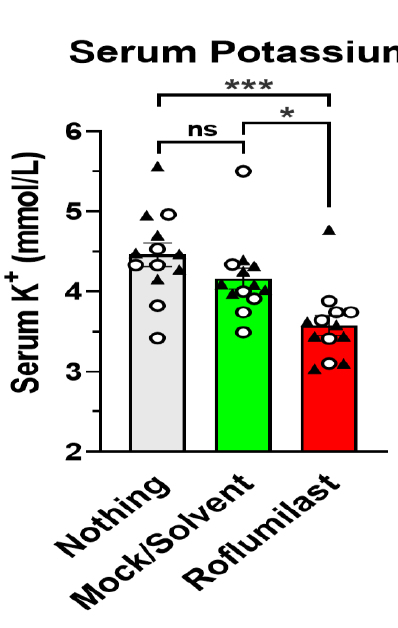
Figure A1. Treatment with the PDE4 inhibitor Roflumilast reduces serum potassium levels. Male (filled triangles) and female (open circles) mice were fasted for 5 h with ad libitum access to water and then divided into three treatment groups: 1. Mice that received no treatment/solution (Nothing), 2. Mice that received an i.p. injection of only the solvent/vehicle, and 3. Mice that received an i.p. injection of the PAN-PDE4 inhibitor Roflumilast (5 mg/kg) dissolved in solvent/vehicle. Blood was collected via cheek bleeds 30 min later and potassium was measured using a blood chemistry analyzer. Data represent the mean ± SEM. Statistical significance was determined using Kruskal– Wallis followed by Dunn’s post hoc test and is indicated as ns ( p > 0.05), * ( p < 0.05), and *** ( p < 0.001).